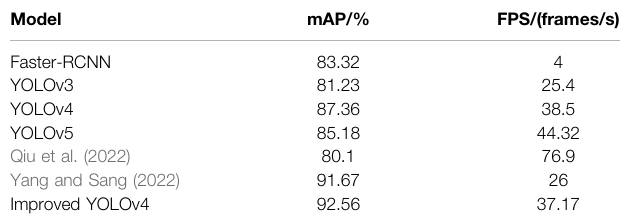
TABLE 1 | Comparison of detection performance of different